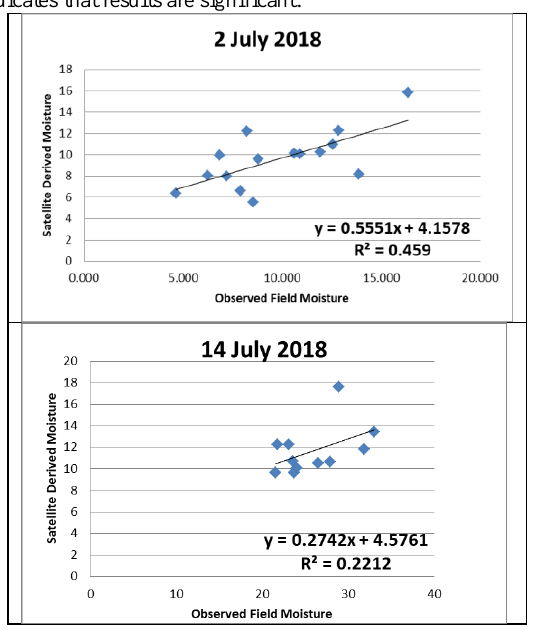
Figure 4. SM proxy method results for 2 nd of July and 14 th